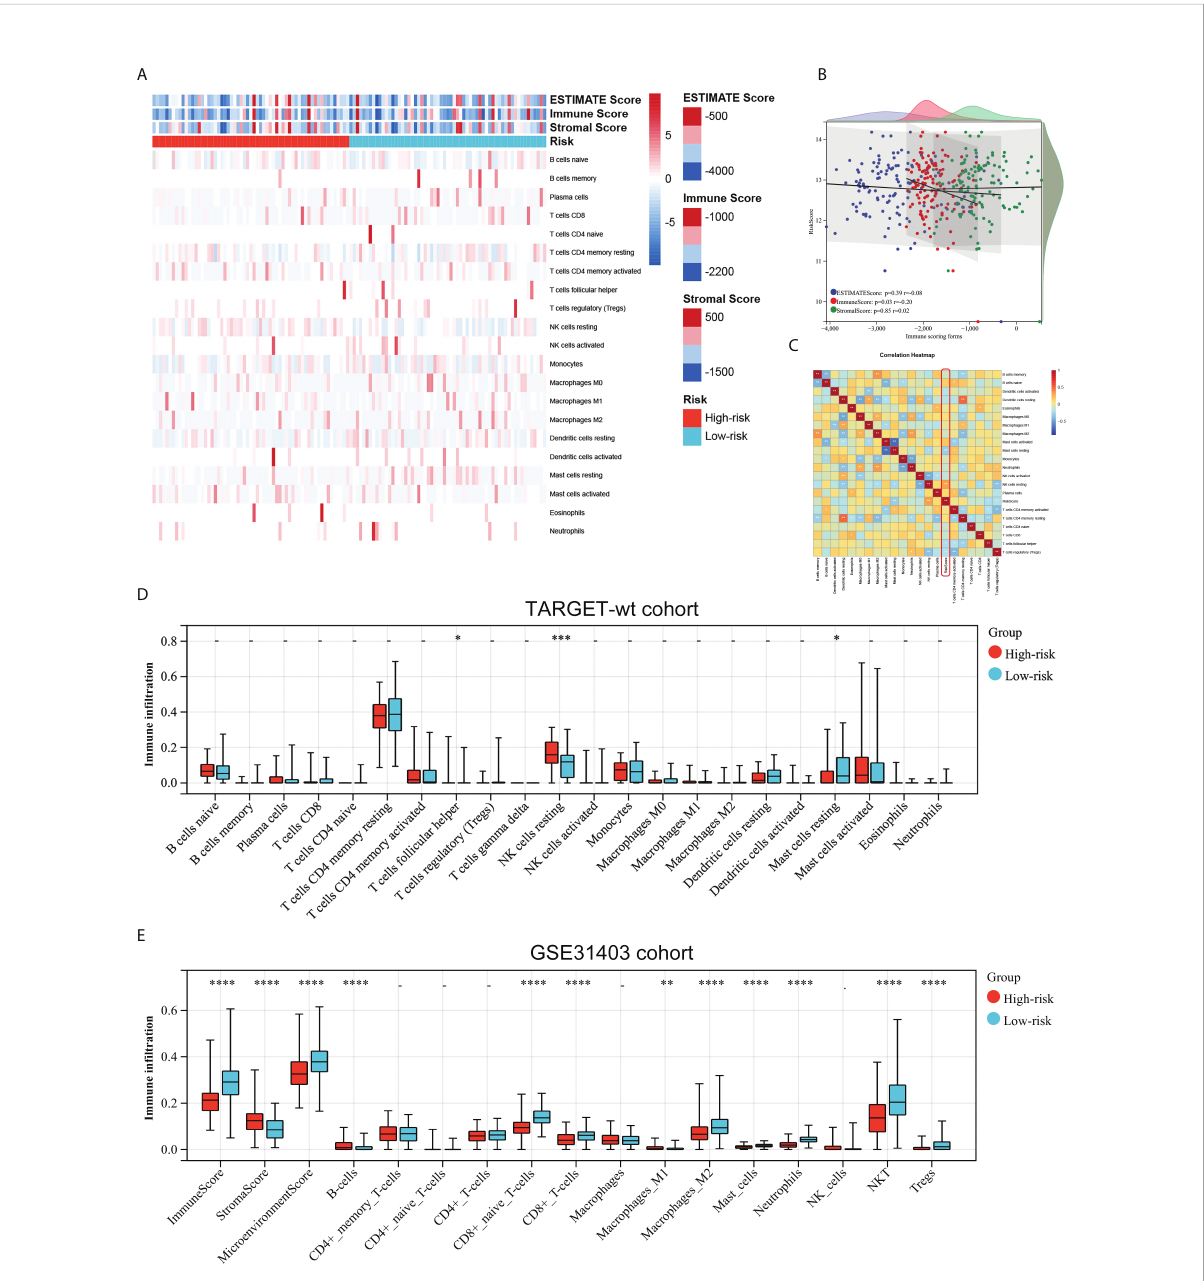
FIGURE 5 Associations between the immune signature and immune in fi ltration. (A) Landscape of the immune characteristics and tumour microenvironment in the TARGET-wt cohort. (B) Scatter plots depicting correlation of the immune-based risk signature with Stromalscore, Immunescore, and Estimatescore. (C) The correlation between 21 types of immune cells and riskscore in Wims tumour. (D, E) Distribution of immune-in fi ltrating cells in high- and low-risk subgroups in the TARGET-wt cohort and GSE31403 cohort. *, **, ***, and **** indicate a signi fi cance level of 0.05, 0.01, 0.001, and 0.0001,